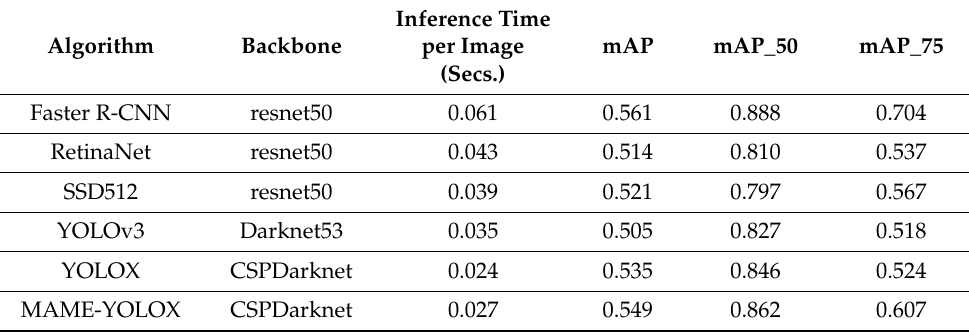
Figure 9. The HRRSD dataset’s visualized test results using different algorithms. Table 4. Comparative experimental results of different algorithms on HRRSD dataset.